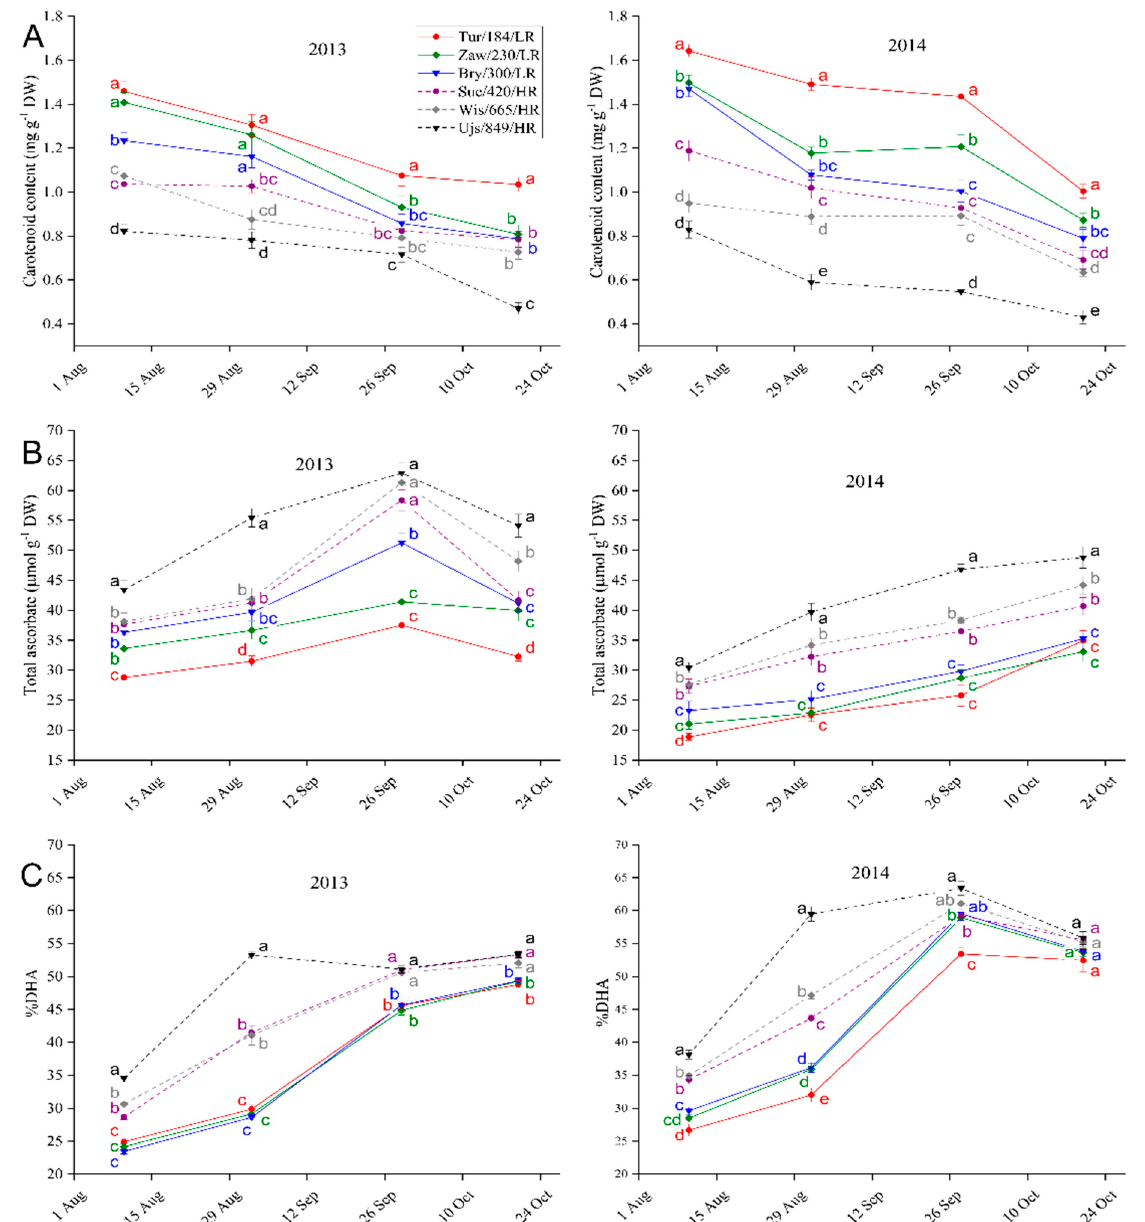
Figure 5. Changes in carotenoid ( A ) and total ascorbate ( B ) content and percentage of DHA ( C ) in the leaves from different provenances of beech trees ( Fagus sylvatica L.). Analyses were performed for provenances from high-altitude (dashed line) and low-altitude (solid line) regions in 2013 and 2014. Each point is the mean of 15 measurements (±SE). Means with different lowercase letters for each sampling date differ significantly at p < 0.05.